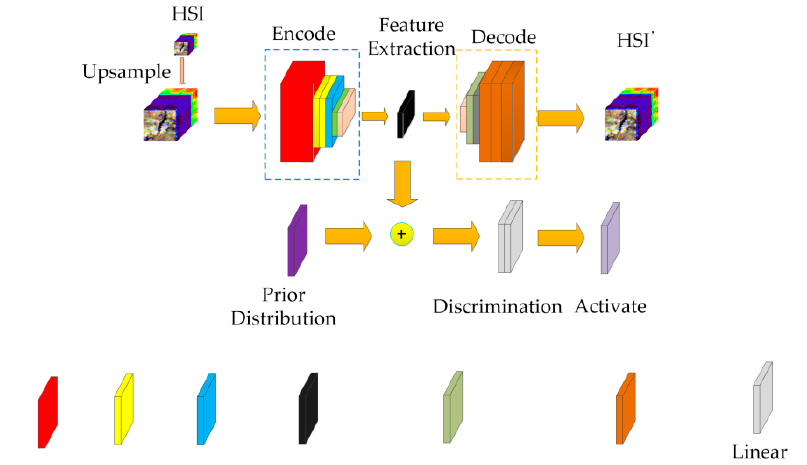
Figure 4. Feature extraction with MAAE for HSI (h-MAAE).